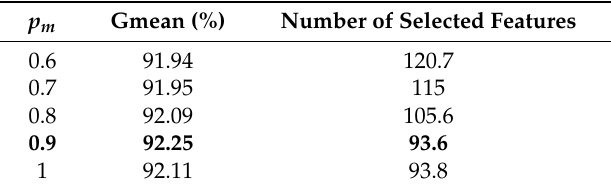
Table 5. Performance with different p m values.